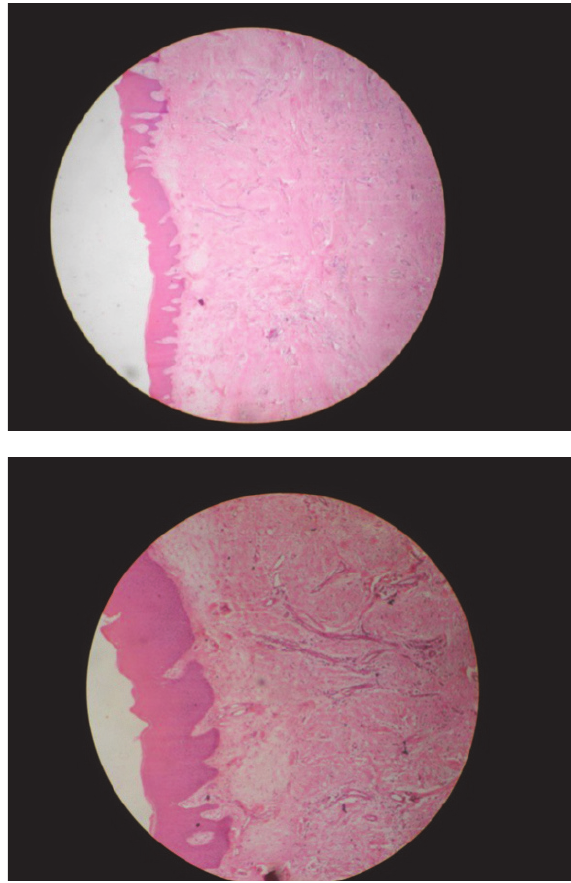
Figure 6: Histopathology.